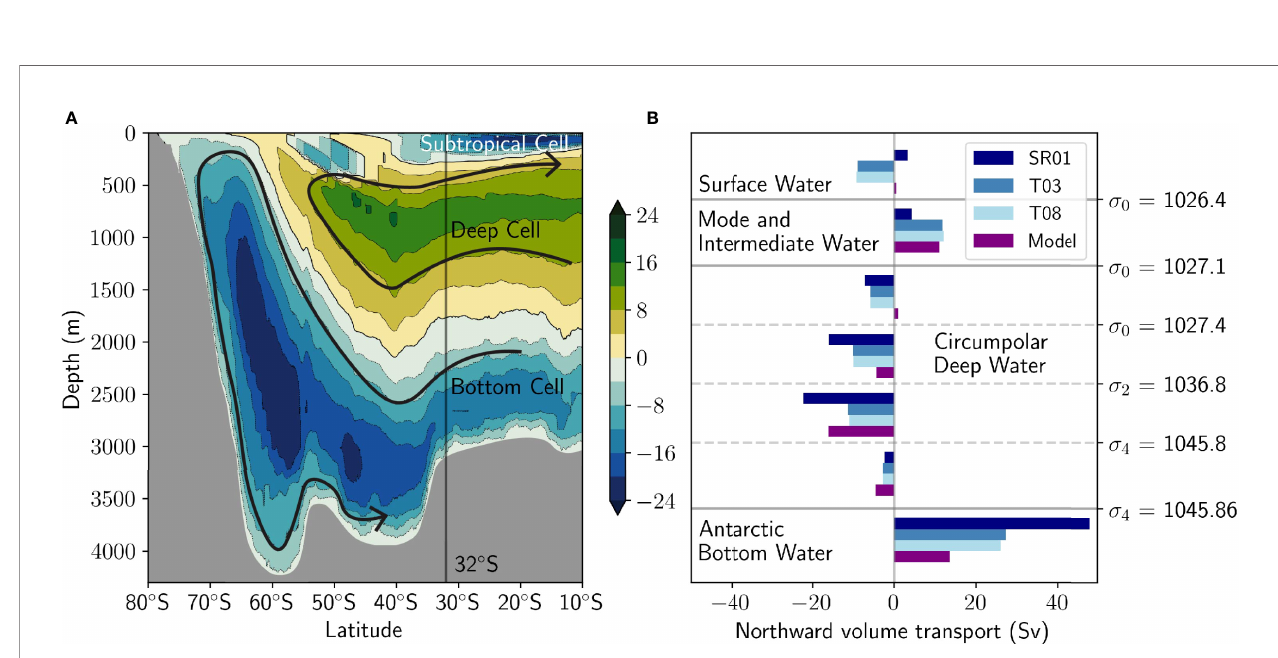
FIGURE 3 | (A) Meridional residual overturning circulation streamfunction in depth coordinates, indicating the fl ow of water along contours. Flow can be interpreted to fl ow clockwise in green regions, and anticlockwise in blue regions along contours, as indicated conceptually by the black arrows. Topography is in grey. (B) Observation-derived estimates of transports at 30-40 °S reported in Sloyan and Rintoul (2001) (SR01), Talley et al. (2003) (T03), and Talley (2008) (T08) are compared to model transports at 32 °S. These transports are calculated for density classes de fi ned by Talley et al. (2003). Additional resolution in density classes is provided for Circumpolar Deep Water compared with the other water mass